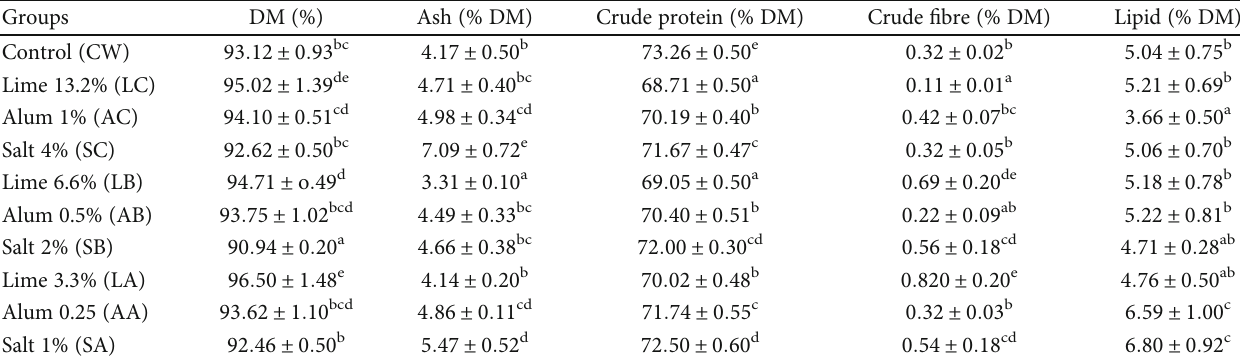
Table 2: Proximate composition of the di ff erent samples of Archachatina marginata meat.